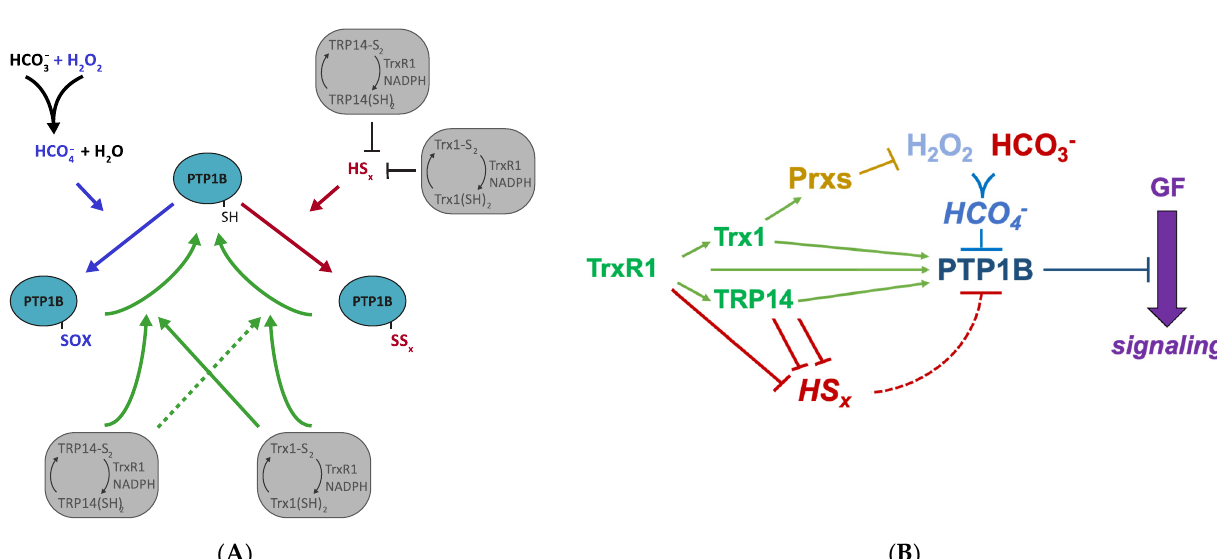
Figure 6. Schemes for the regulation of PTP1B activity by the Trx1 or TRP14 systems in relation to oxidation by either polysulfides or peroxymonocarbonate. ( A ) Model scheme summarizing the data and interpretations of this study, showing how PTP1B activity can be regulated by different redox dependent mechanisms through H 2 O 2 /HCO 3 − and the Trx1 or TRP14 systems. The reaction of H 2 O 2 together with HCO 3 − yields peroxymonocarbonate (HCO 4 − ), which oxidizes PTP1B to forms (“PTP1B SOX ”), including a sulfenylamide [12] , that are amenable to reactivation by either Trx1 or TRP14 (green arrows). Polysulfides (“HS x ”, red) are potently reduced by either Trx1 or TRP14, whereby these enzyme systems indirectly prevent polysulfides from inhibiting PTP1B. Once persulfidated PTP1B has been formed (“PTP1B SSx ”), this can mainly be reactivated by Trx1 but not as efficiently with TRP14 (dashed green arrow). The figure in ( B ) illustrates schematically how the activities of the Trx/TRP14/TrxR1 system together with Peroxiredoxins (Prxs) can maintain PTP1B activity in a cellular context, with Trx1-depdendent Prxs counteracting H 2 O 2 accumulation, both Trx1 and TRP14 reducing polysulfides, and both systems being able to reduce and thereby reactivate oxidatively inactivated PTP1B. From our results in the present study, we conclude that polysulfide-mediated inhibition of PTP1B (dashed red arrow) must overcome the very potent direct reduction of polysulfides seen with the Trx1 and TRP14 systems, while H 2 O 2 together with HCO 3 − yielding peroxymonocarbonate (HCO 4 − ) can inhibit PTP1B also in the presence of active Trx1 and TRP14 systems. Ultimately the extent of PTP1B activity will control growth-factor (GF) signaling, with more inhibited PTP1B allowing for more signaling activity.